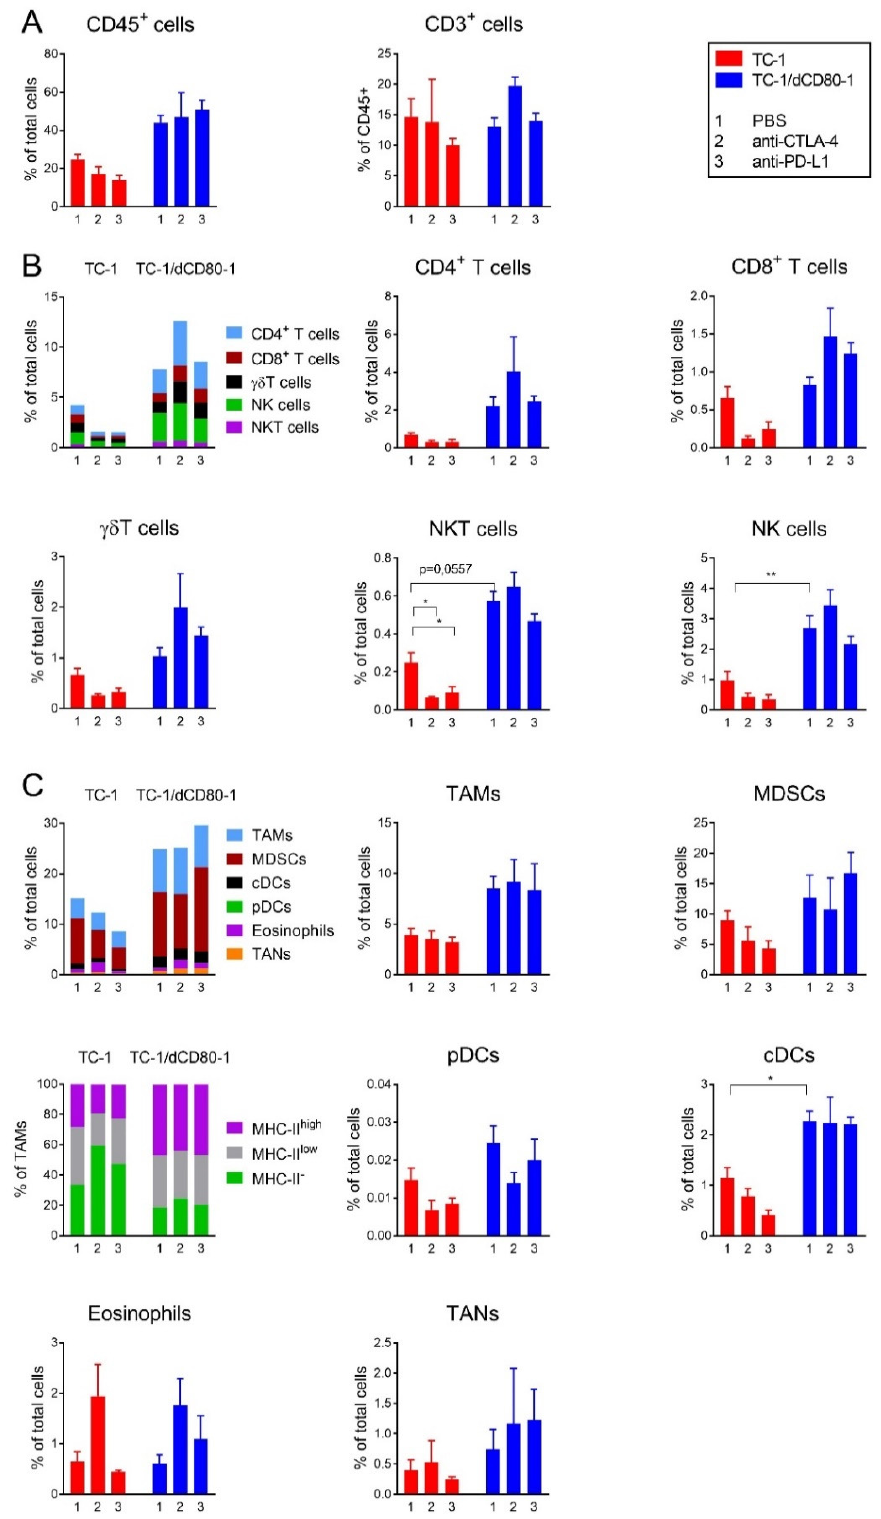
Figure 5. Flow cytometry analysis of immune cells infiltrating TC-1- and TC-1/dCD80-1-induced tumors. Mice ( n = 4) were treated with anti-CTLA-4 or anti-PD-L1 and PBS was used as the control. The total infiltration by immune cells and the proportion of lymphocytes were determined using CD45 and CD3 markers, respectively ( A ). Cell subpopulations were stained with panels of antibodies detecting either lymphoid ( B ) or myeloid cells ( C ). Bars indicate ±SEM; * p < 0.05, ** p < 0.01.